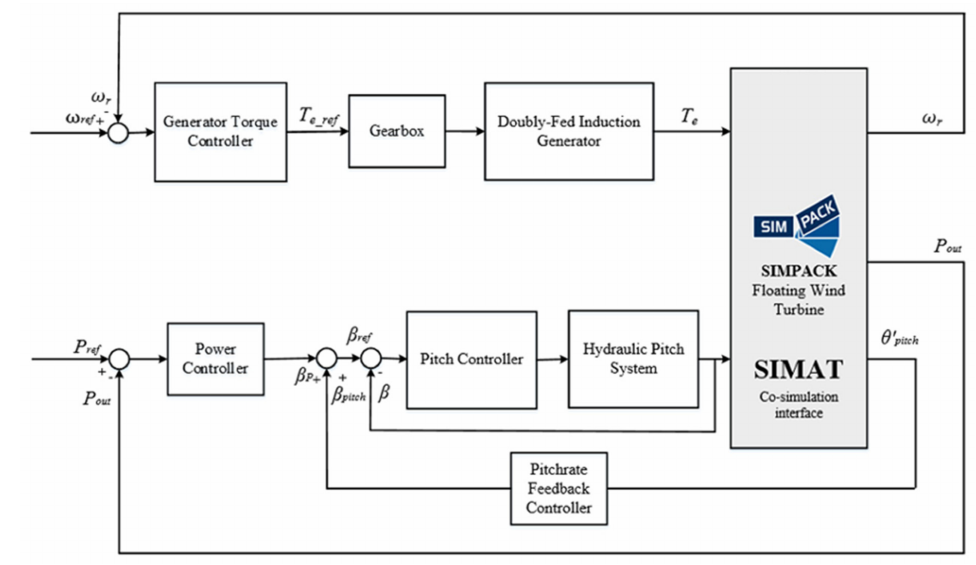
Figure 12. Wind Turbine Overall-Control-System Block